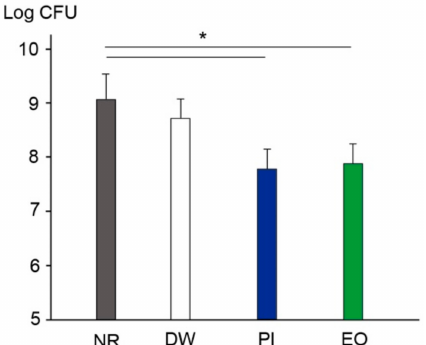
Figure 5. Viable counts in the mouth after rinsing with distilled water or mouthwash containing PI or EO. Results are shown as means ± SD. * p <